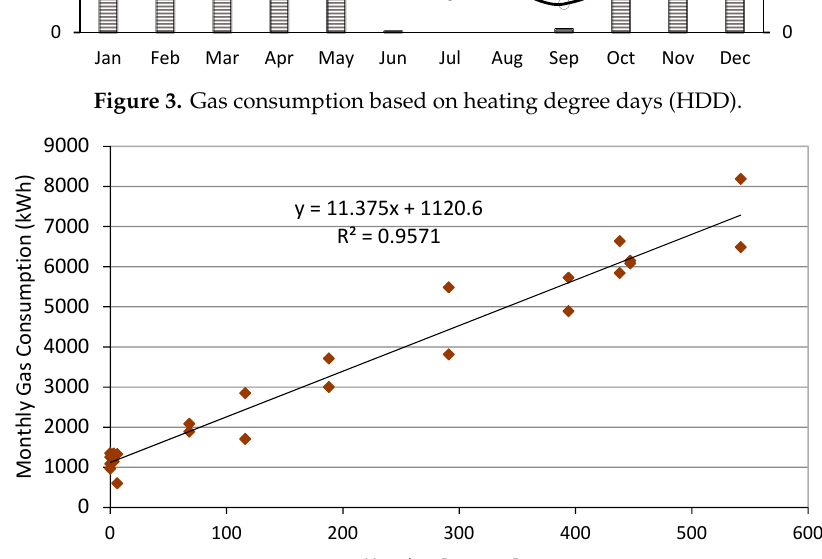
Figure 4. Linear regression between the natural gas consumption and the heating degree days (HDD).